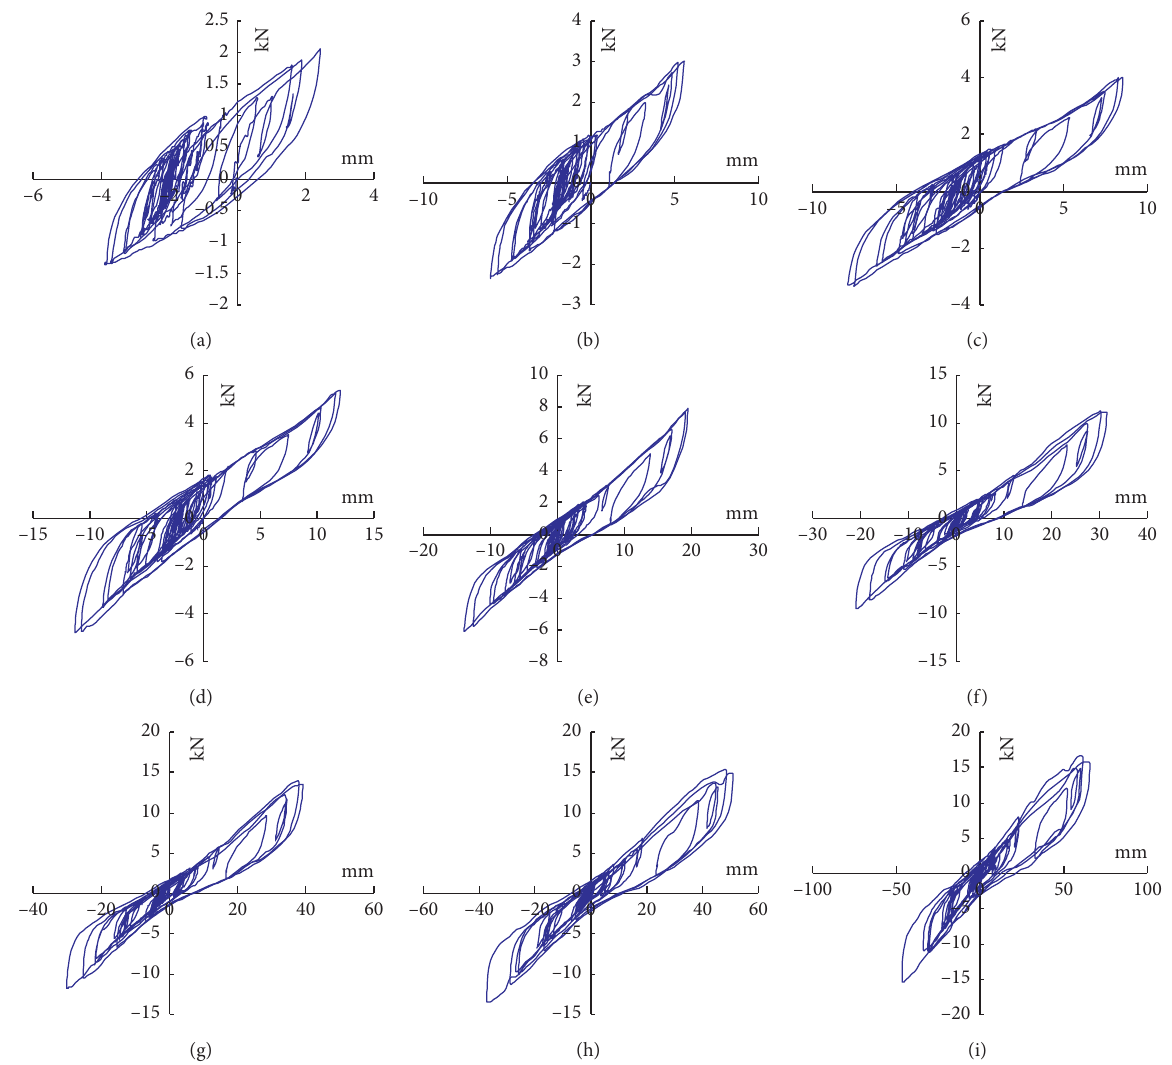
Figure 11: MLQT-4 hysteretic curve: (a) 70 gal; (b) 100 gal; (c) 200 gal; (d) 280 gal; (e) 400 gal; (f) 620 gal; (g) 800 gal; (h) 1000